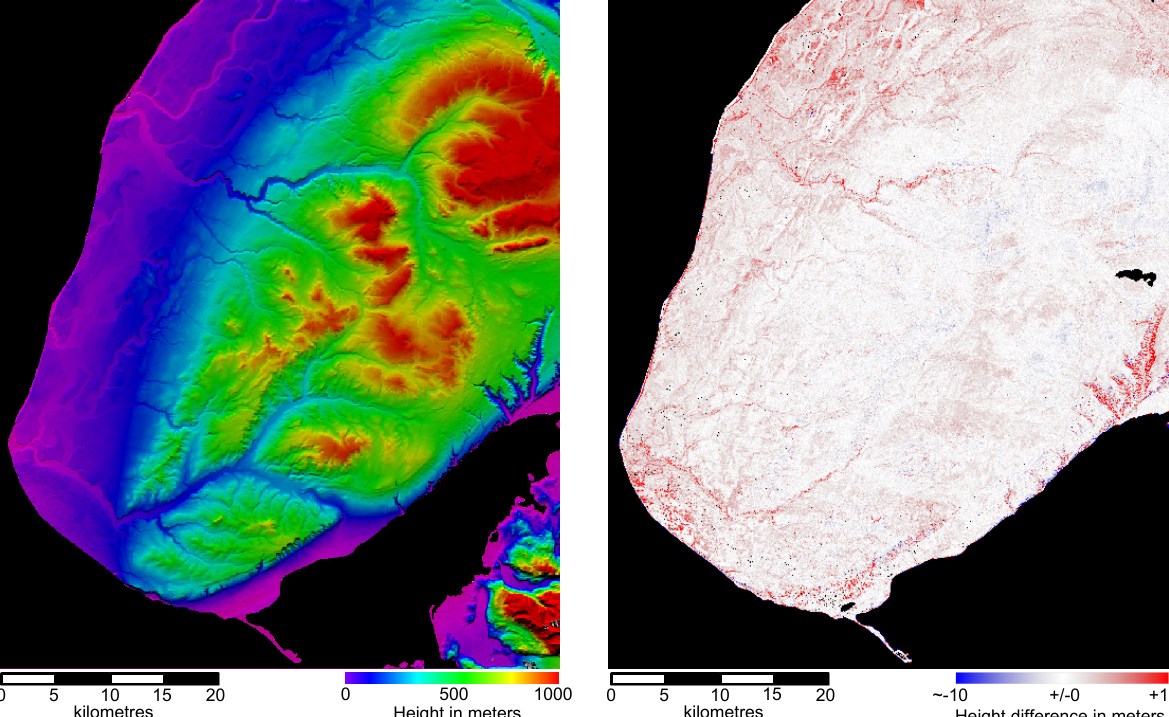
Figure 6. Painted relief image of the DSM-tile data on the validation area, which has the height range of approx. 0~900 m, selected from the reference LiDAR/DEM (left) and the height difference image between DSM-tile data and the reference LiDAR/DEM data (DSM-tile minus LiDAR/DEM) (right). The black areas in the painted relief image represent the mask of the sea, while ones in the difference image represent masks which were not used in the validation. Table 5. Basic specification of the LiDAR/DEM dataset